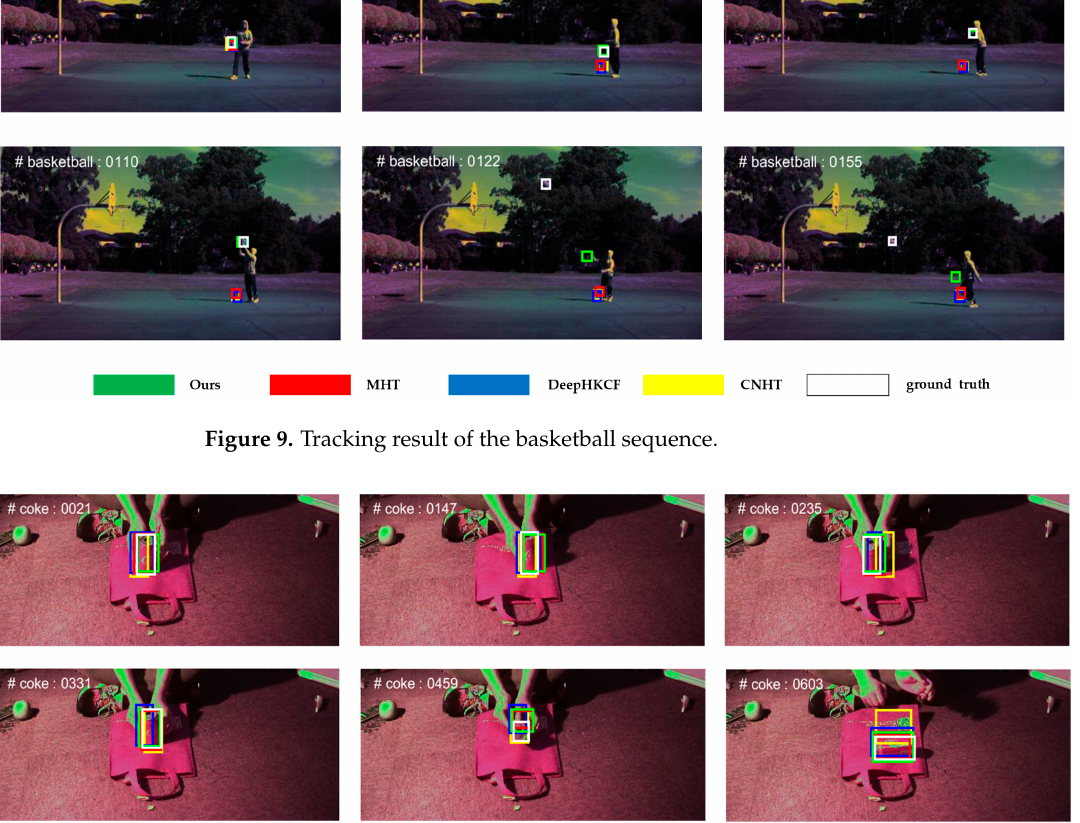
Figure 10. Tracking result of the coke sequence.